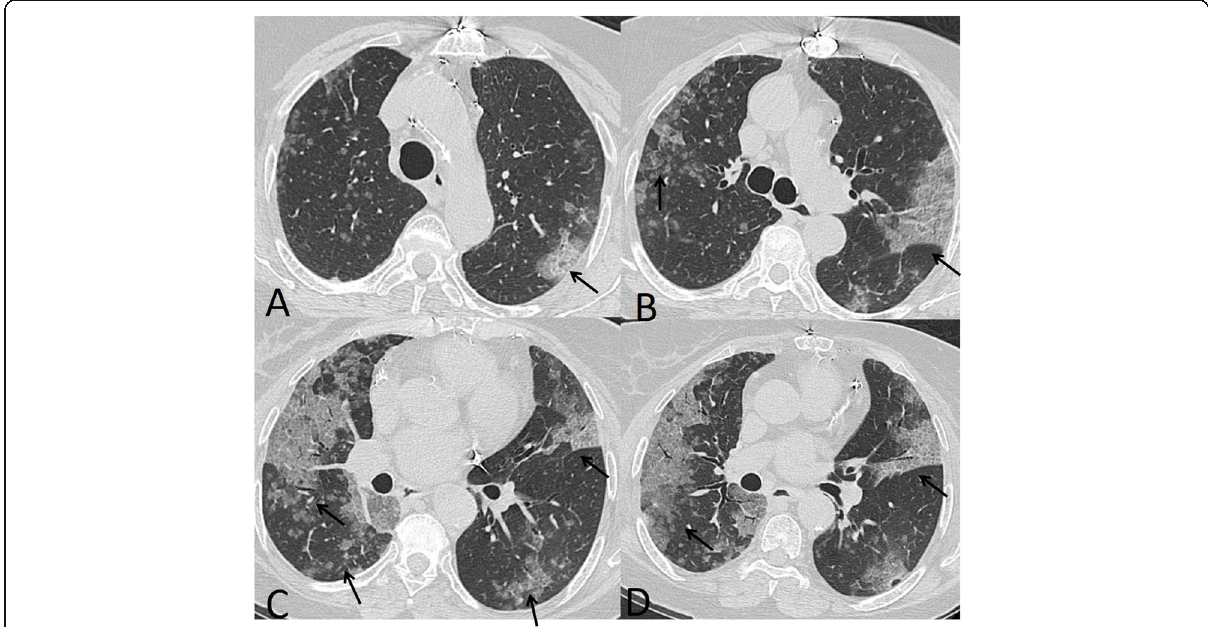
Fig. 6 A 57-year-old male with mild involvement of the right upper lobe with multiple rounded nodules of GGO (black arrow b ), moderate involvement of the left upper lobe with patchy crazy paving (black arrows in a and b ), and severe involvement of the right middle lobe and both lower lobes with patchy crazy paving and air bronchogram (black arrows in c and d ). Total severity score =